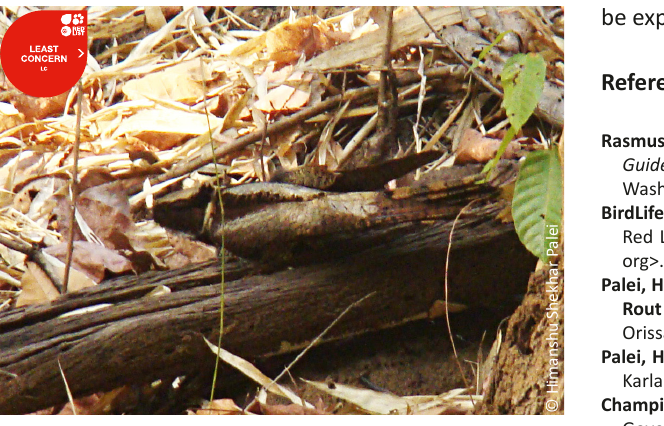
Image 1. Great Eared-Nightjar at Jakam in Karlapat Wildlife Sanctuary, Odisha,